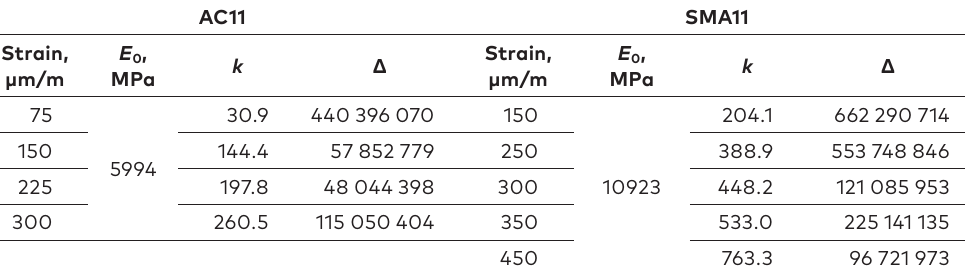
Table 2. Results of the regression analysis with fixed initial